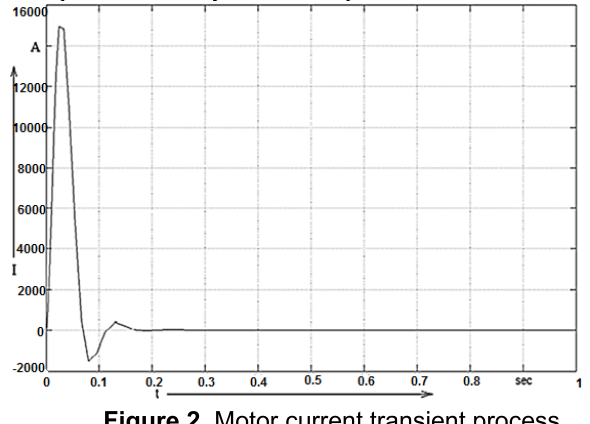
Figure 1. Structural diagram of a drive with subor dinate current and speed control